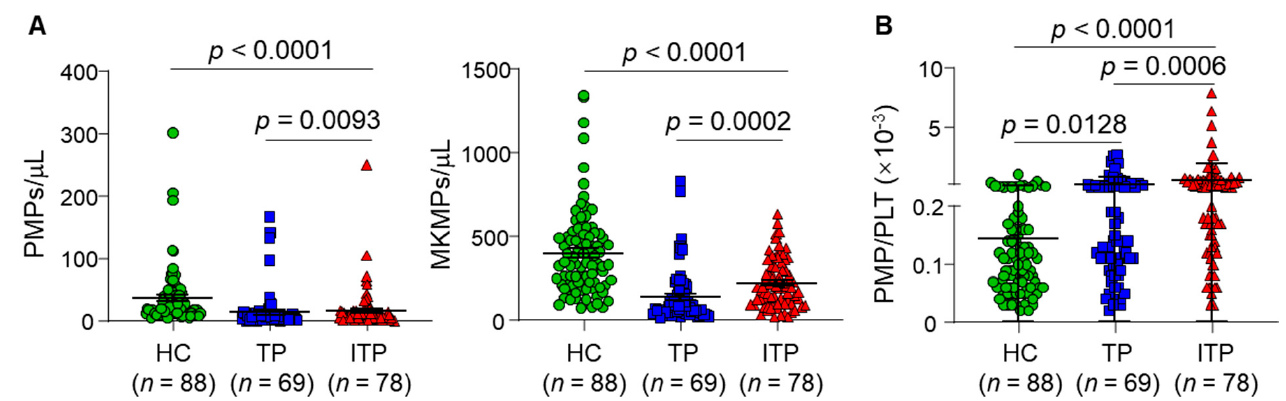
Figure 2. Plasma PMP and MKMP levels and PMP/PLT ratios in ITP patients: ( A ) Plasma profiles of MKMPs and PMPs in healthy controls (HC) ( n = 88) and TP ( n = 69) and ITP ( n = 78) patients; ( B ) PMP levels were normalized to platelet counts as PMP/PLT ratios in HC ( n = 88) and TP ( n = 69) and ITP ( n = 78) patients. Data are presented in the scatter plot view (Mean ± SEM).